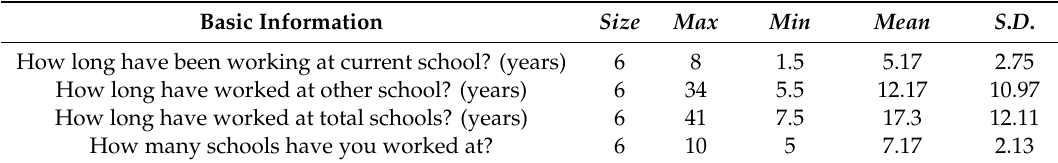
Table 2. Interviewee